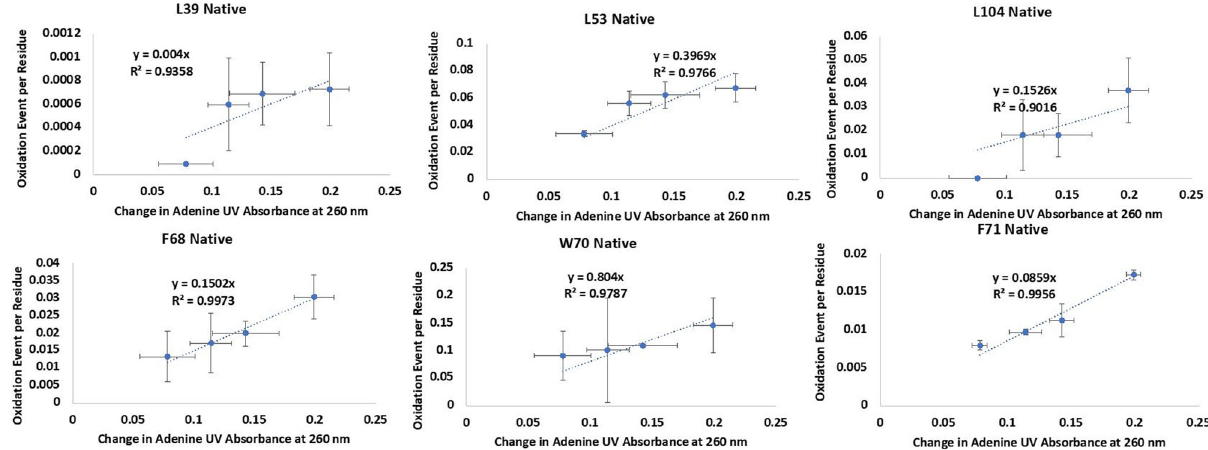
Fig. 1 Measured radical dose response rate of six amino acids used for structural modeling in NRG1-Ig via HR-HRPF. Each fi gure shows the calculated oxidation of each residue at four different hydrogen peroxide concentrations plotted against the changes in adenine absorbance at 260 nm. The error bars represent one standard deviation from triplicate measurements for each data point. Each point represents the oxidation of one residue at a speci fi c radical dose. The slopes of best- fi t lines are radical dose responses.